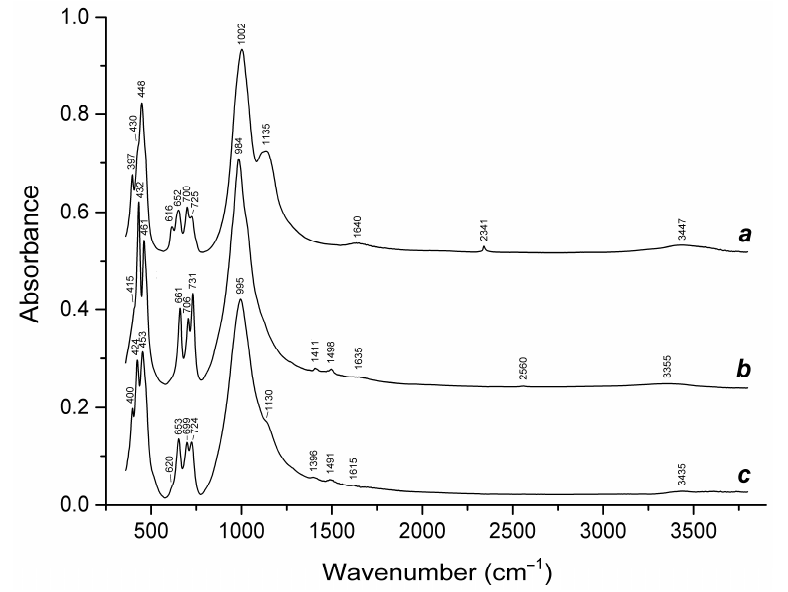
Figure 6. Infrared spectra of ( a ) initial haüyne (Sample 2), ( b ) Sample 2 preheated for three days at 700 ◦ C, over the Fe-FeS buffer, and ( c ) preheated Sample 2 additionally annealed at 800 ◦ C in air for one day.